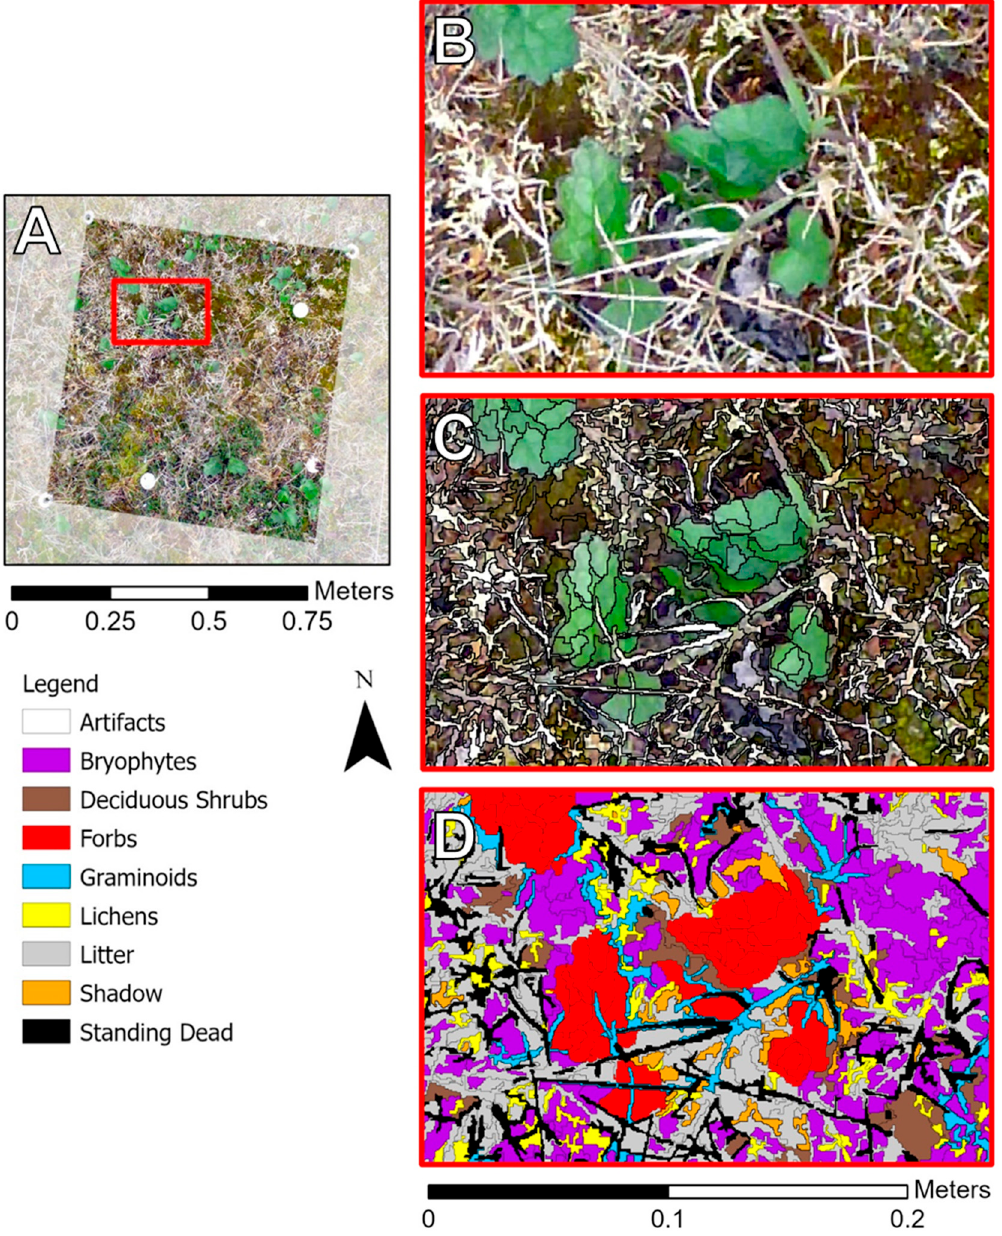
Figure 3. Example of the image segmentation and classification of a plot. ( A ) The extent of the plot image is 0.75 m 2 , cropped according to the footprint of the point frame. Scale is increased to show the ( B ) vegetation in the plot, ( C ) primitive image objects as a result of multi-resolution segmentation, and ( D ) final classification of the image objects using the optimal random forest model.